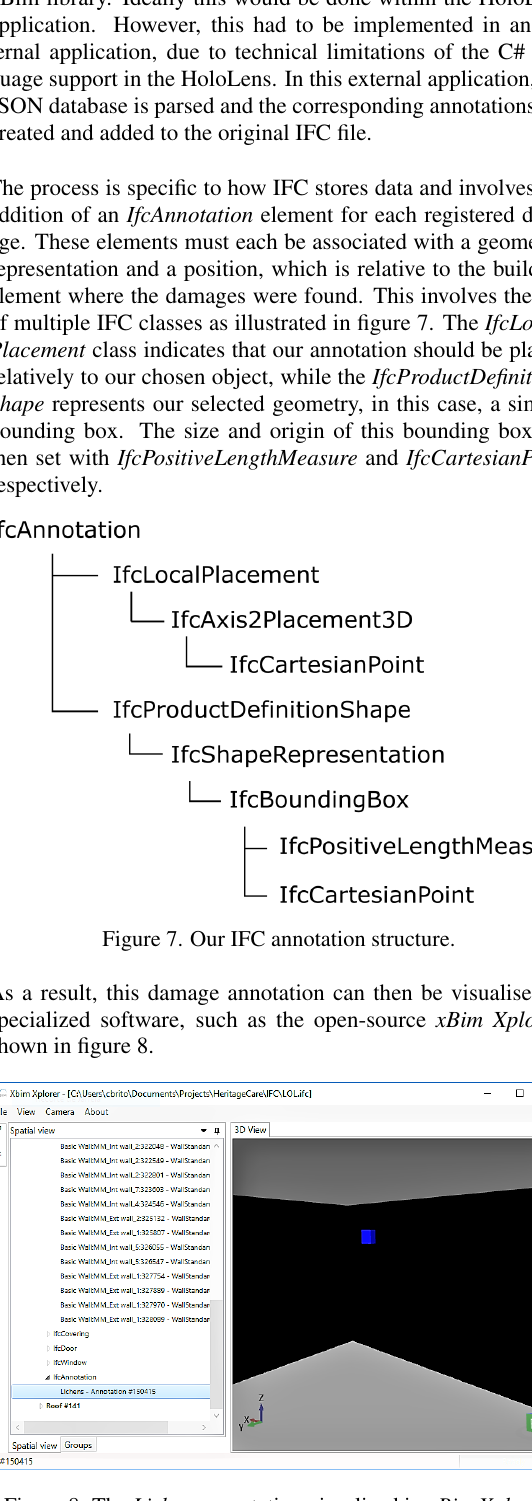
Figure 8. The Lichens annotation visualized in xBim Xplorer